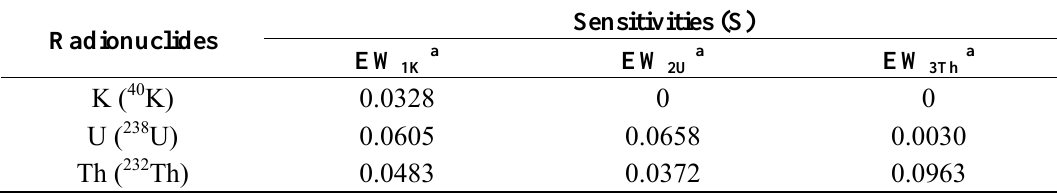
Table 3. Sensitivities (S) of EWs calculated from the standard spectra of